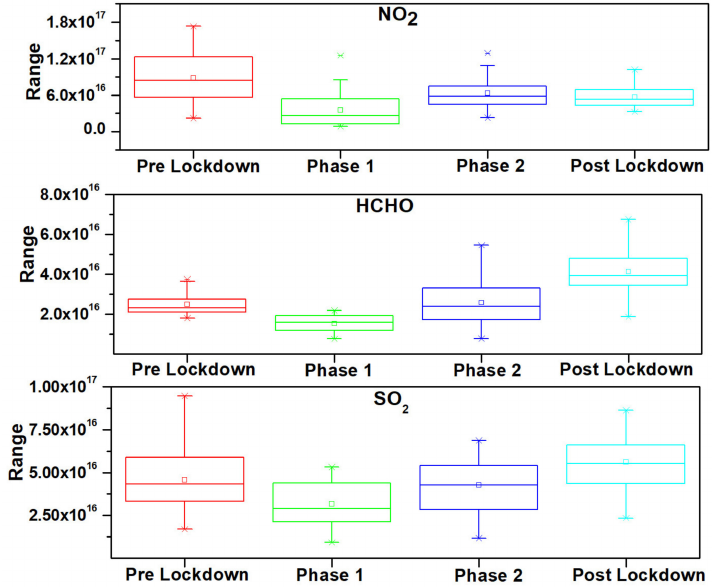
Figure 4. Boxplot for NO 2 , HCHO, and SO 2 VCDs obtained from MAX-DOAS observations for the study period over